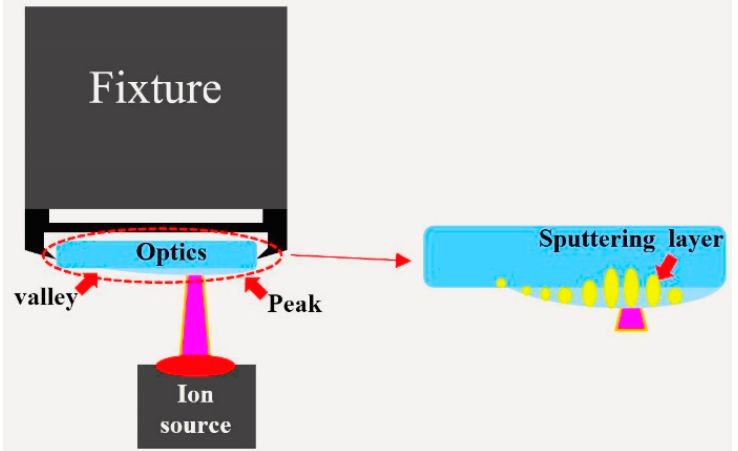
Figure 8. Sputtering damage layer formation process.